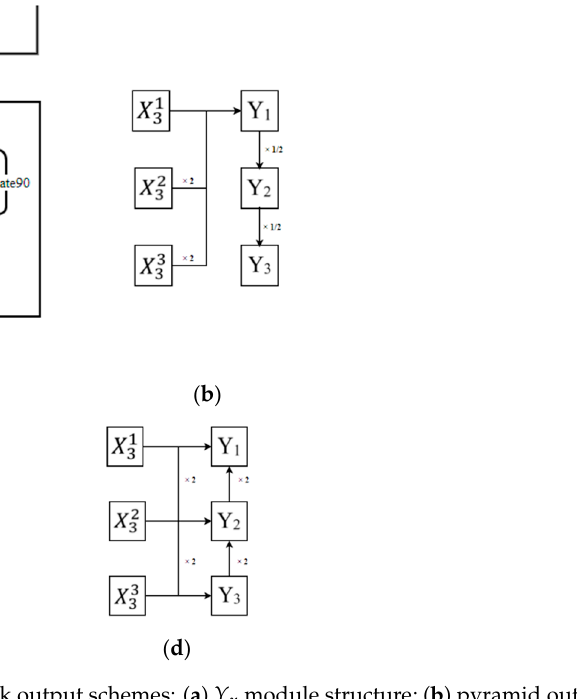
Figure 3. Network output schemes: ( a ) Y x module structure; ( b ) pyramid output mode; ( c ) advanced pyramid output mode; ( d ) high-resolution output mode.